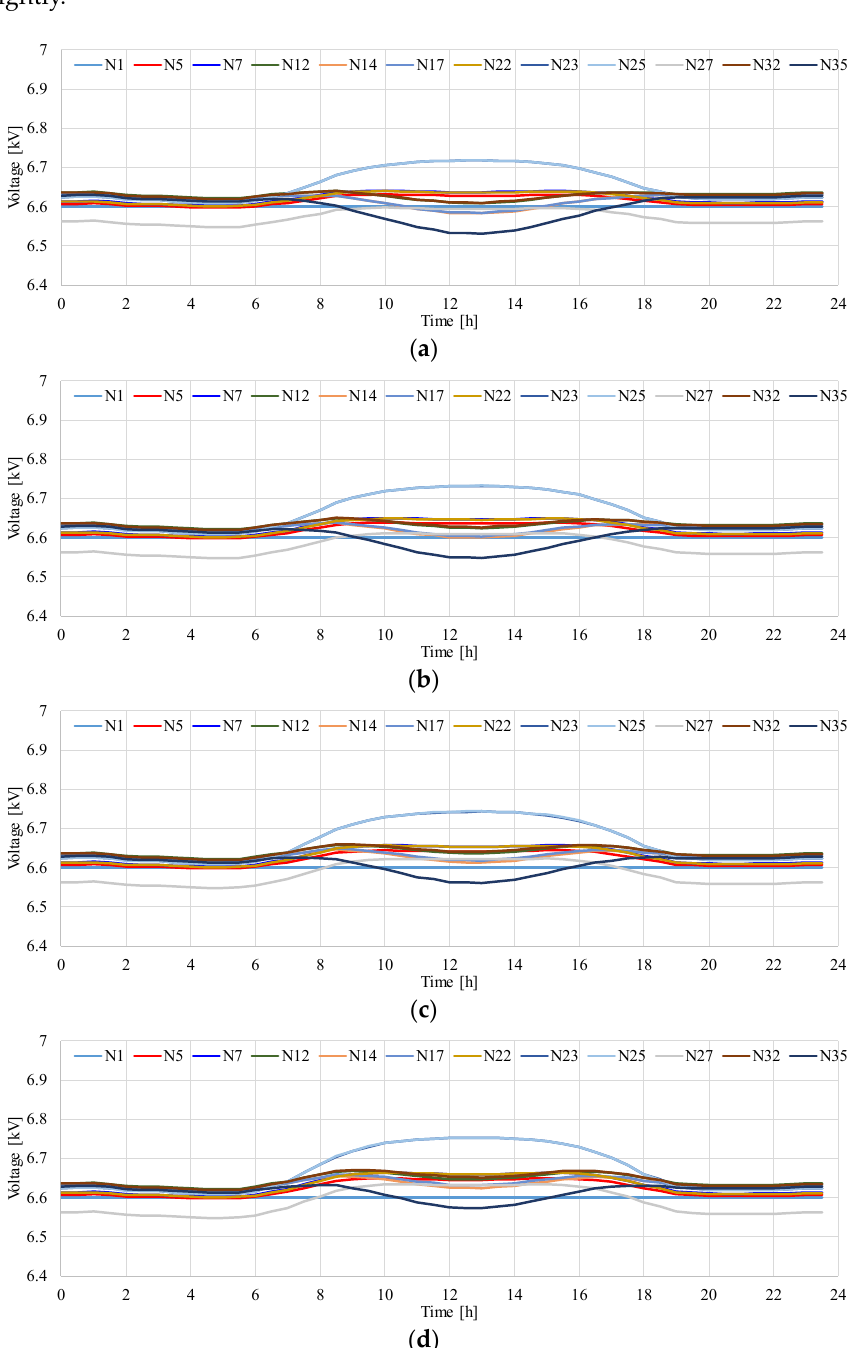
Figure 10. Time variation in voltage at MV distribution feeder with PCS for which the power factor is set to 1.0: ( a ) Case A1; ( b ) Case B1; ( c ) Case C1; ( d ) Case D1.